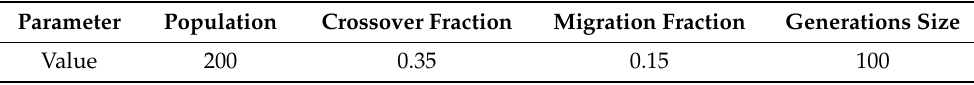
Table 5. Tuning parameters of genetic algorithm.